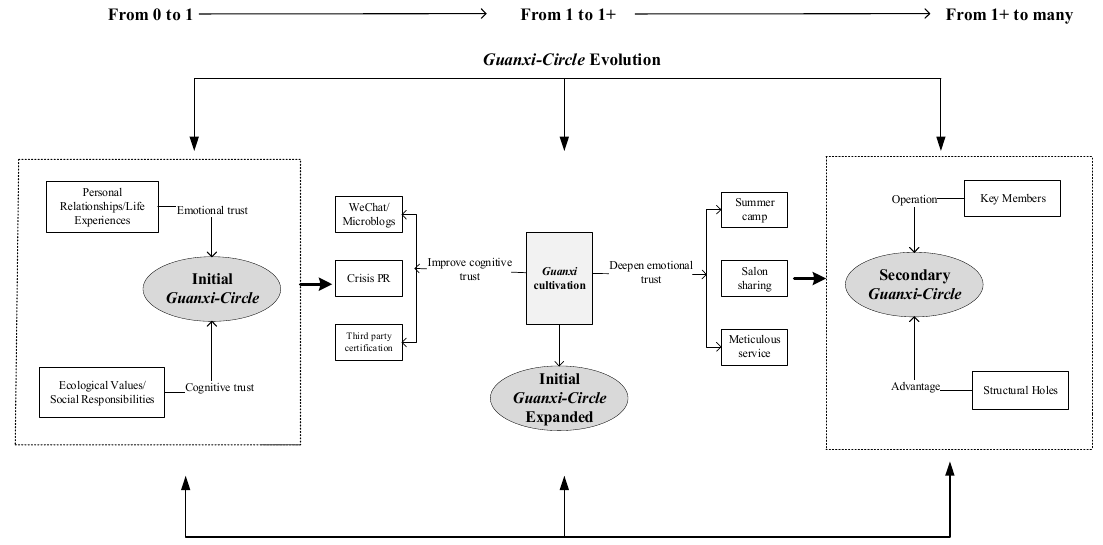
Figure 2. Three-stages framework of community building in AFNs.